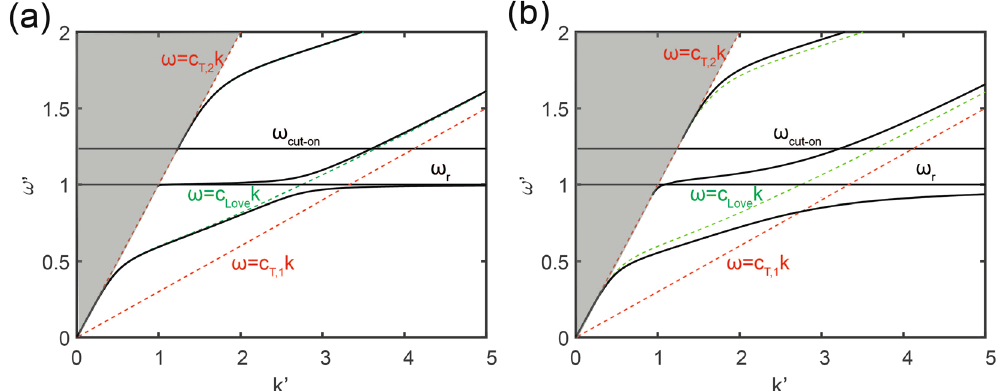
Figure 2. Dispersion relation of Love waves interacting with a metasurface of horizontal resonators (solid curves) as per Eq. (2) for ( a ) F = 0.005 and ( b ) F = 0.05. The dashed green curves correspond to the classical Love wave solutions (no resonators). The dashed red curves mark the bulk speeds in the upper layer ( c T ,1 ) and in the substrate ( c T ,2 ), respectively. The graded area identifies the “sound cone” where SH-bulk waves exist only in the